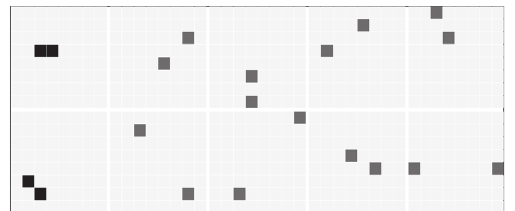
Figure 16: Camera composed of 10 arrays of SIPMs. Each array is readout by one ASIC with 8 × 8 channels. On the left, pixels in black forming a clusters can be seen, while the other fired pixels represent examples of